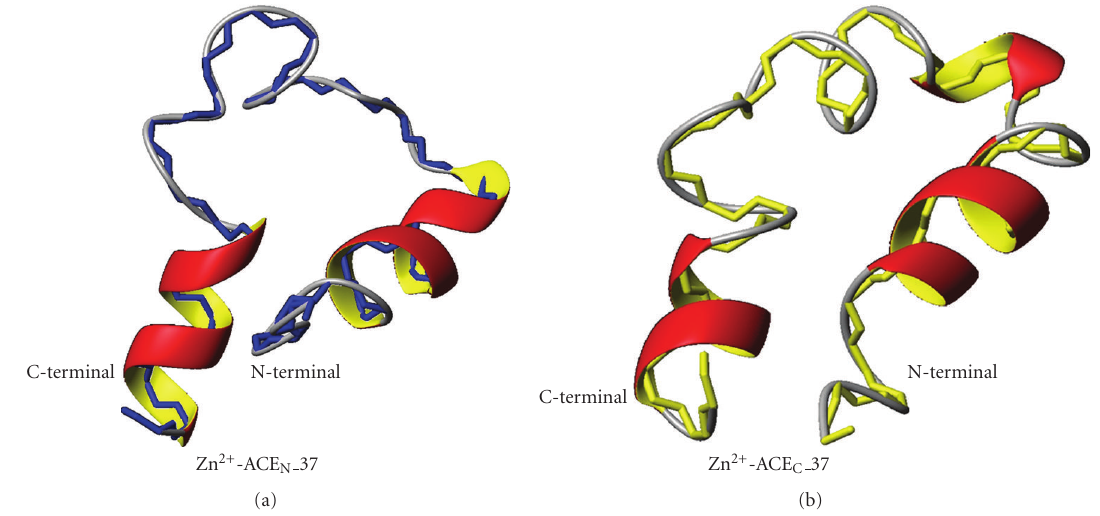
Figure 8: Backbone and ribbon representation of the solution structures of both Zn 2+ -ACE N (37) (a) (corresponds to His 360 -Ala 396 of the human somatic form) and Zn 2+ -ACE C (37) (b) (corresponds to His 958 - Ala 994 of the human somatic form).